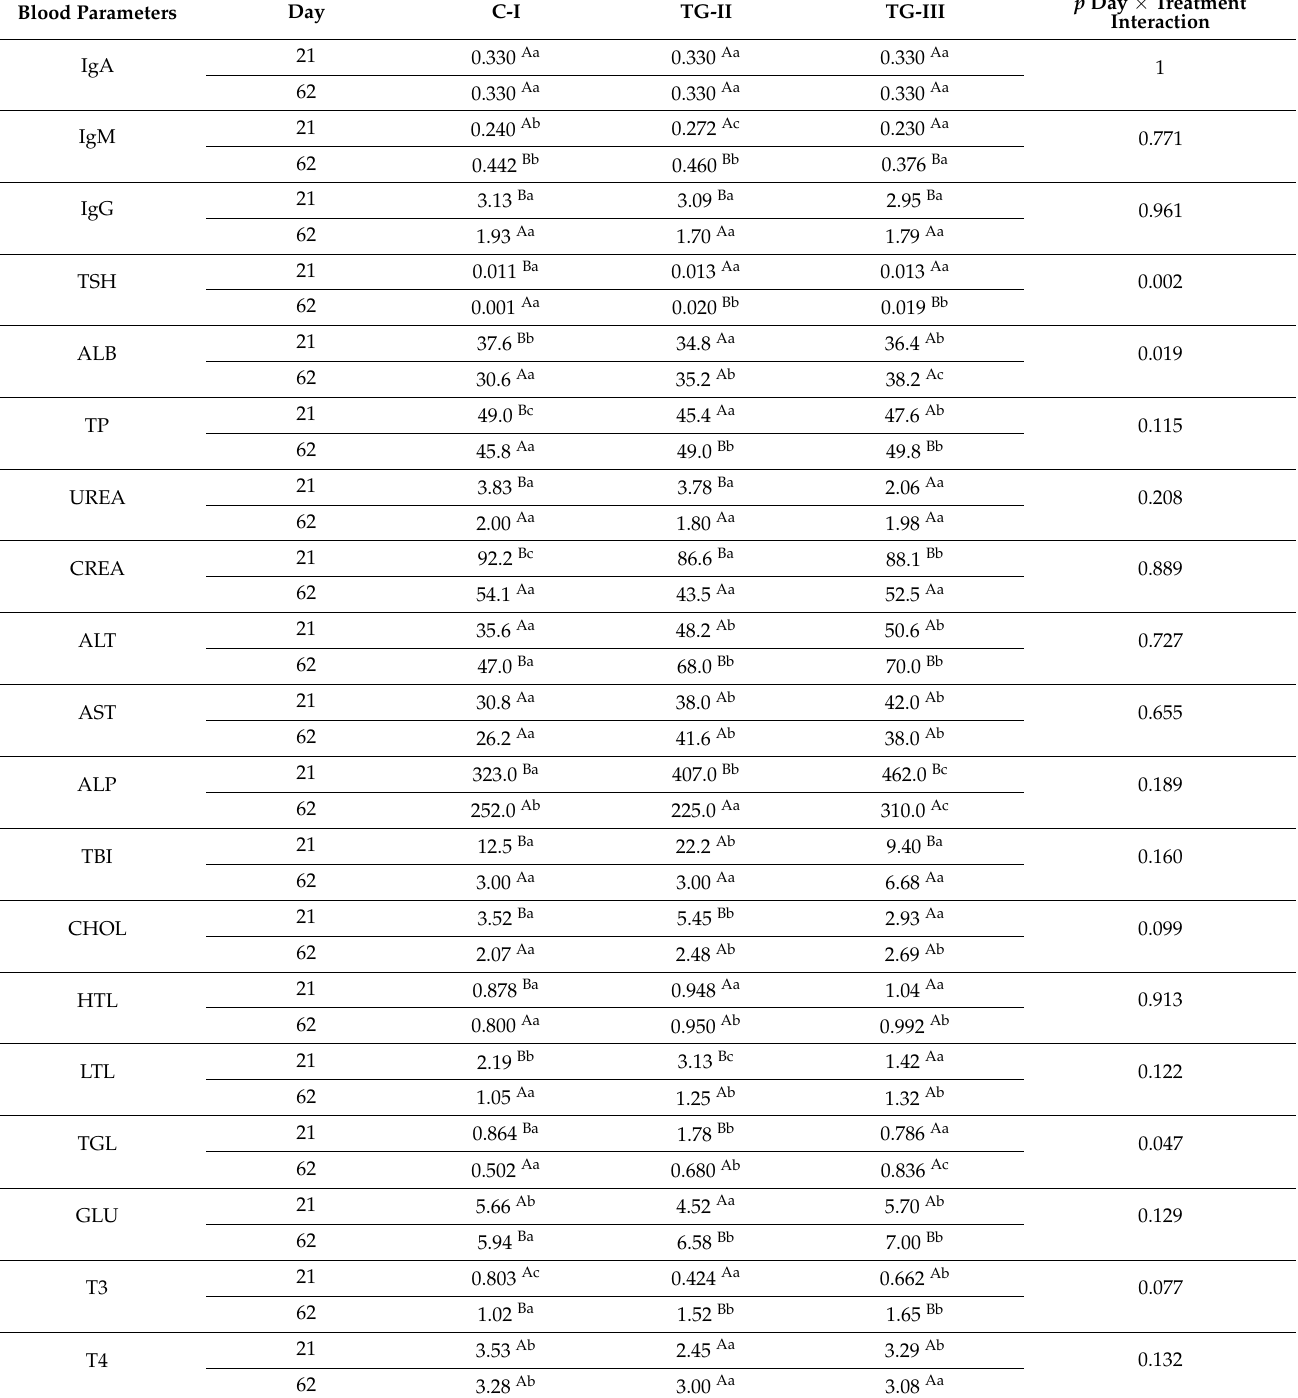
Table 4. Blood parameters of the